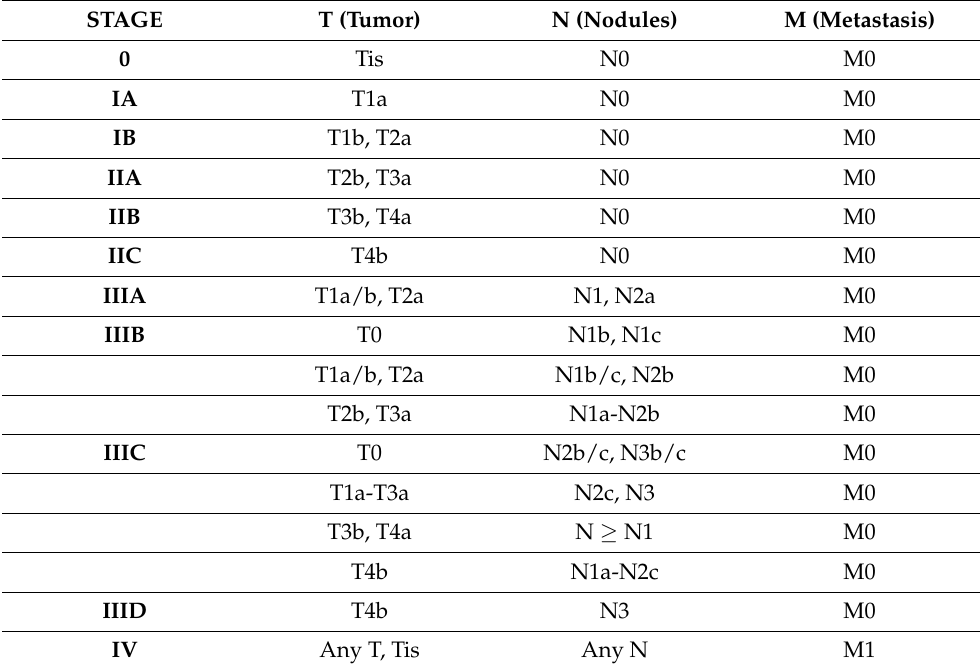
Table 4. American Joint Committee—prognostic stage group for melanoma 2017